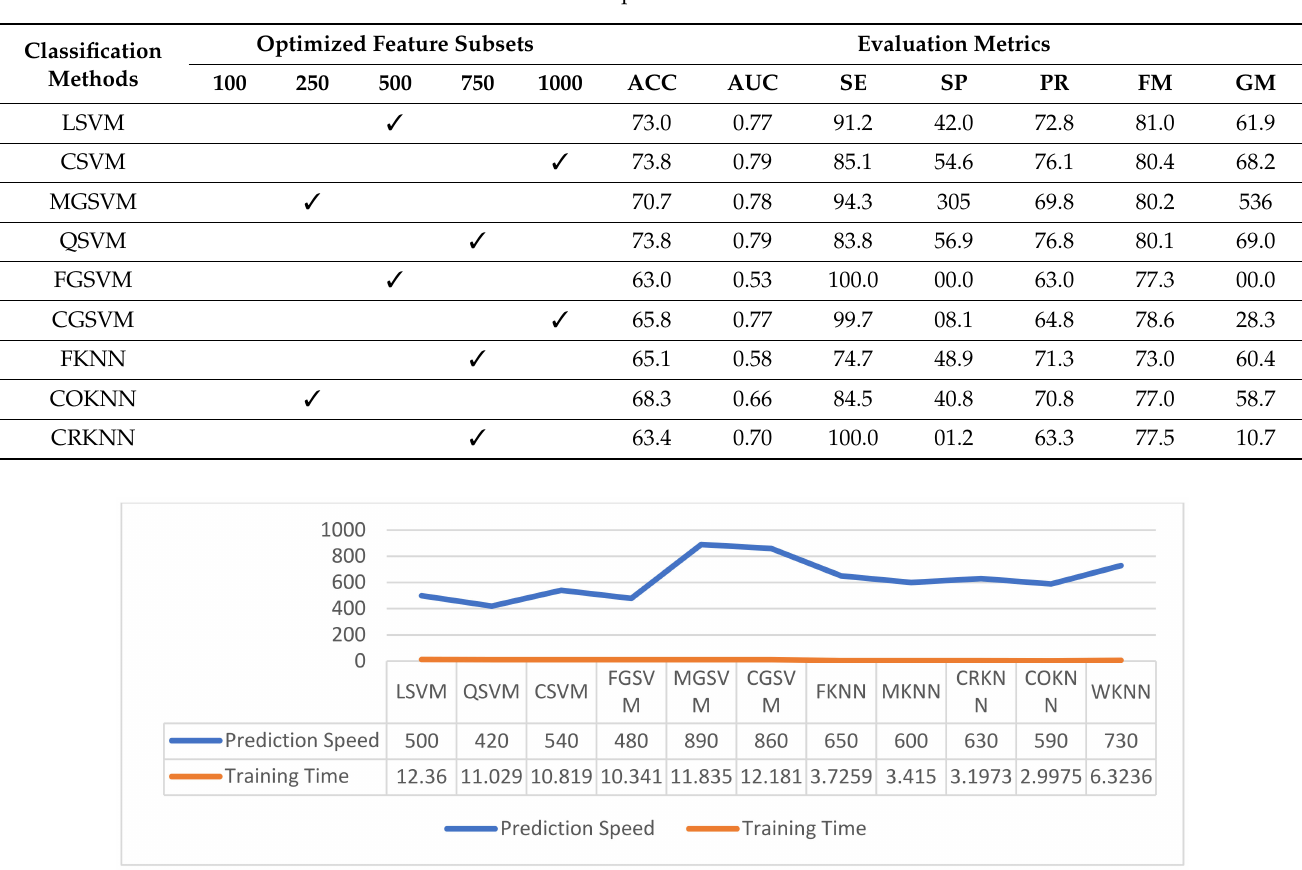
Table 7. Back view-based experimental results on MIT dataset.